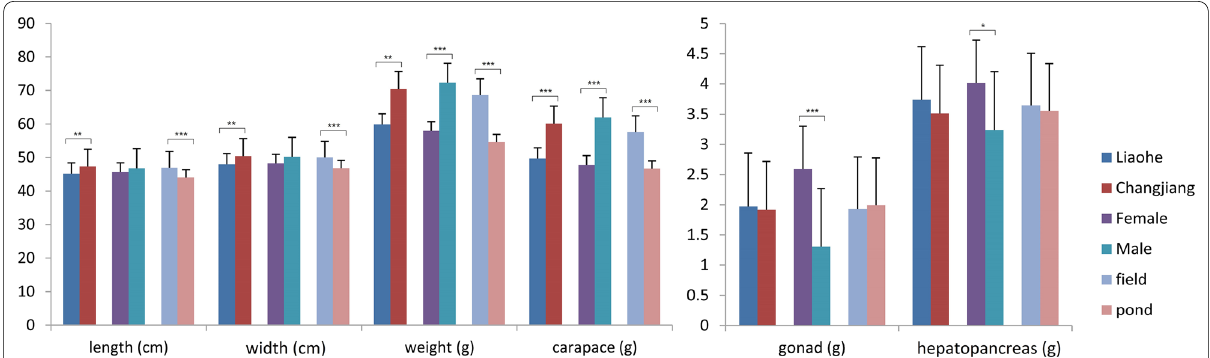
Fig. 1 Body length, width, and weight and wet weight of the carapace, gonad, and hepatopancreas of the sampled Chinese mitten crabs cultured in rice fields and aquaculture ponds. Field and pond, crabs cultured in rice fields and aquaculture ponds; Liaohe and Changjiang, two varieties of Chinese mitten